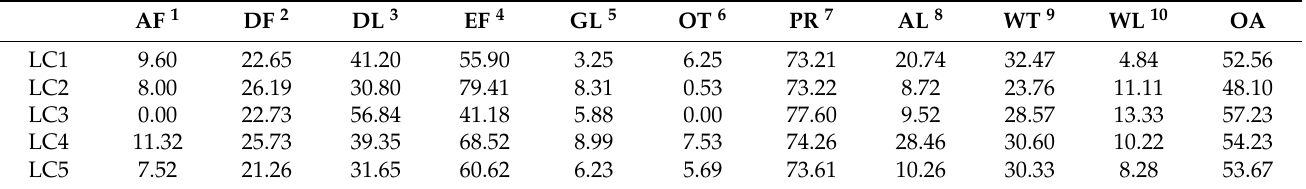
Figure 15. Fusion results using the maximum-posterior possibility measure based on the PBF method in the Mun River Basin. ( a ) is the zoomed-in view of the PBF data, ( b ) is the zoomed-in view of the Landsat classification results, ( c ) is the zoomed-in view of the MODIS classification results, and ( d ) is the zoomed-in view of the manually interpreted map. Table 5. Class-wise and overall classification accuracy (%) obtained for MODIS, Landsat, PBF and two ESTARFM-based methods in the Mun River